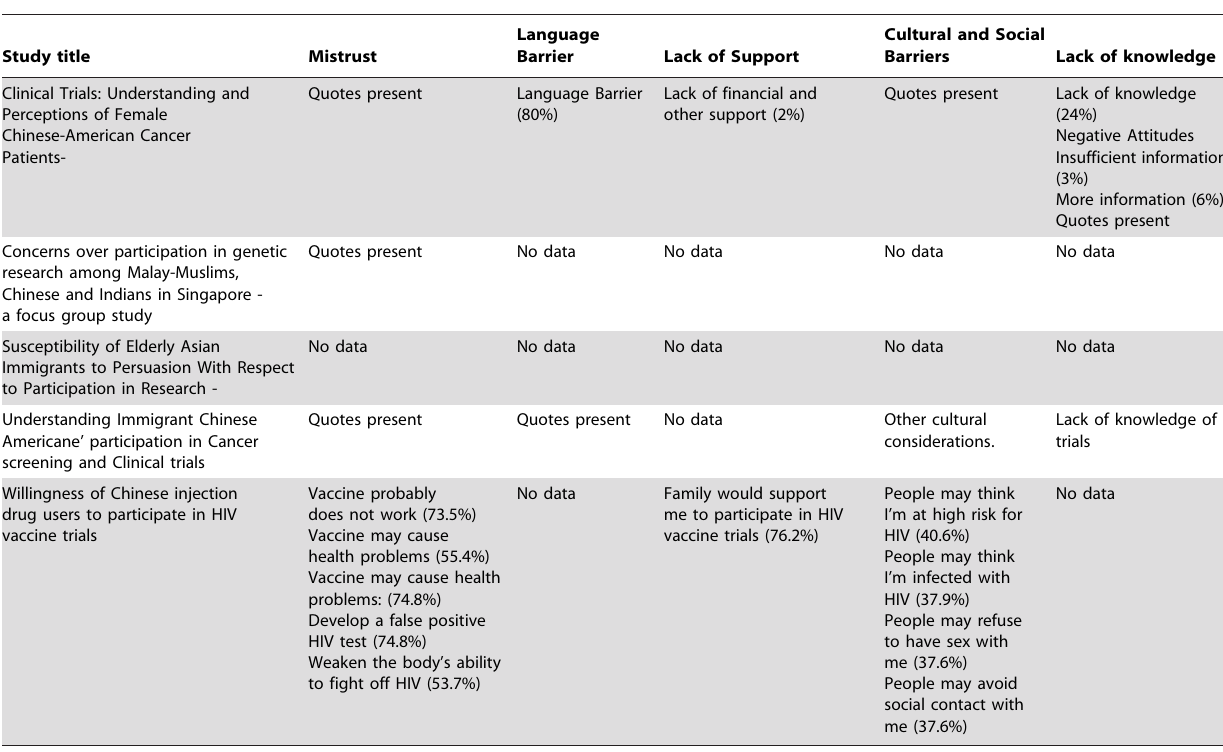
Table 2. Factors serving as barrier to participation in clinical